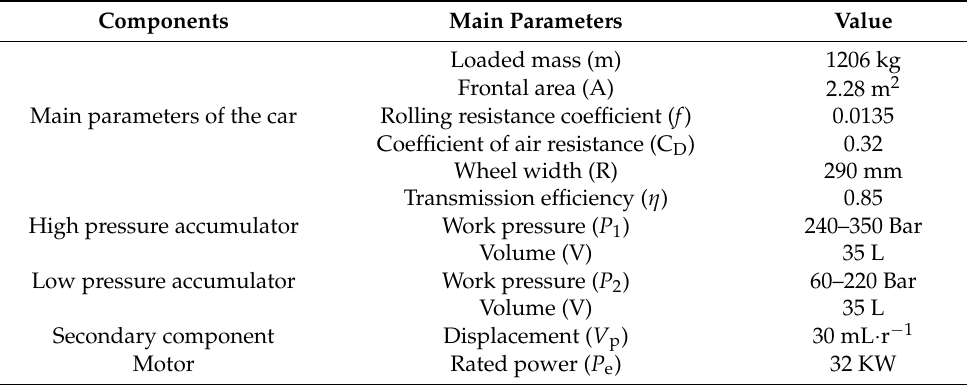
Table 1. Main parameters of the MEHPC-EV.